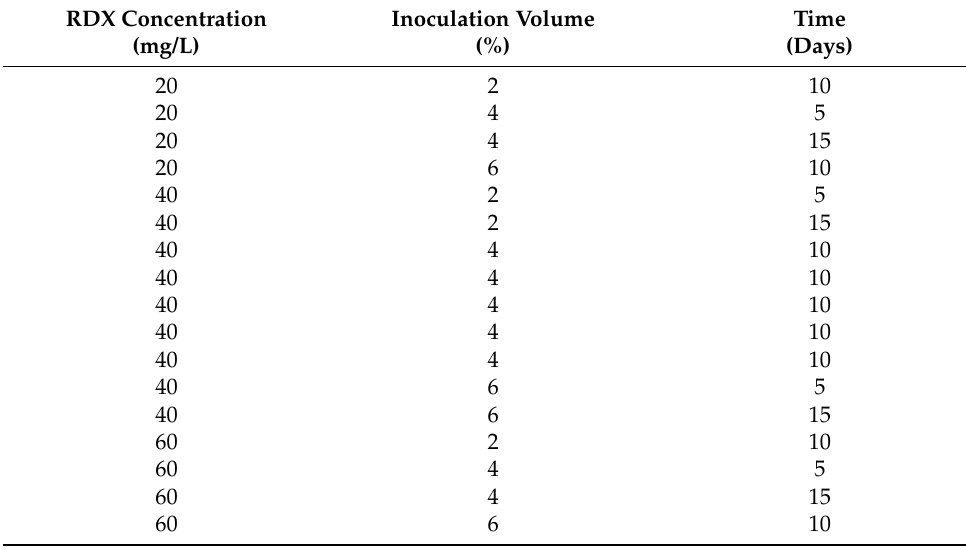
Table 1. Different runs for optimization of parameters for RDX